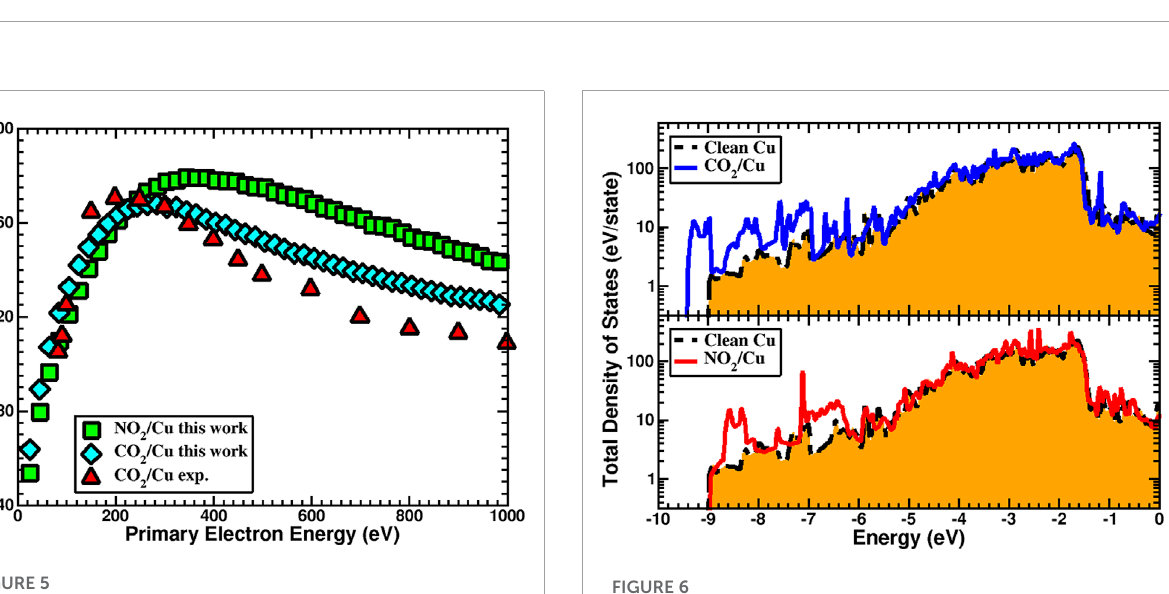
FIGURE 6 Calculated total density of states for CO 2 /Cu (top) and NO 2 /Cu (bottom), and their comparison with clean Cu. The CO 2 layer shows a weaker bonding to Cu surface compared to NO 2 . The Fermi energy level is set at zero for all